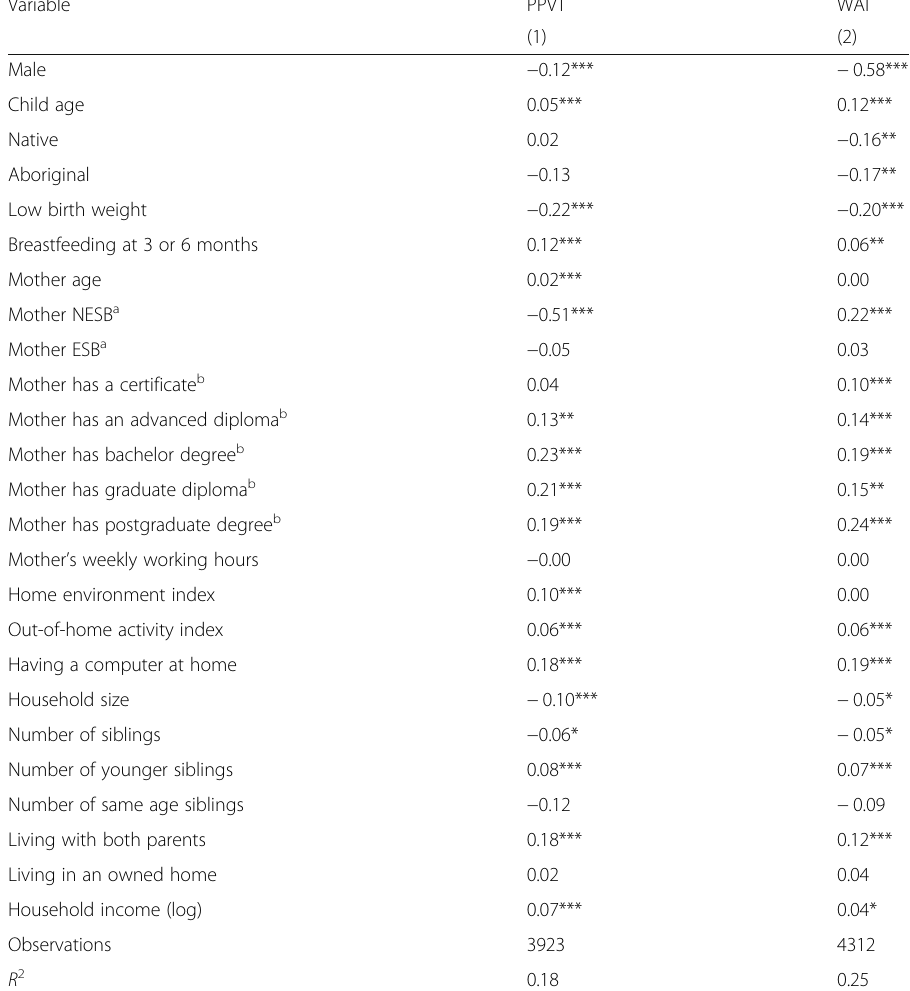
Table 8 Associations between initial PPVT and WAI with